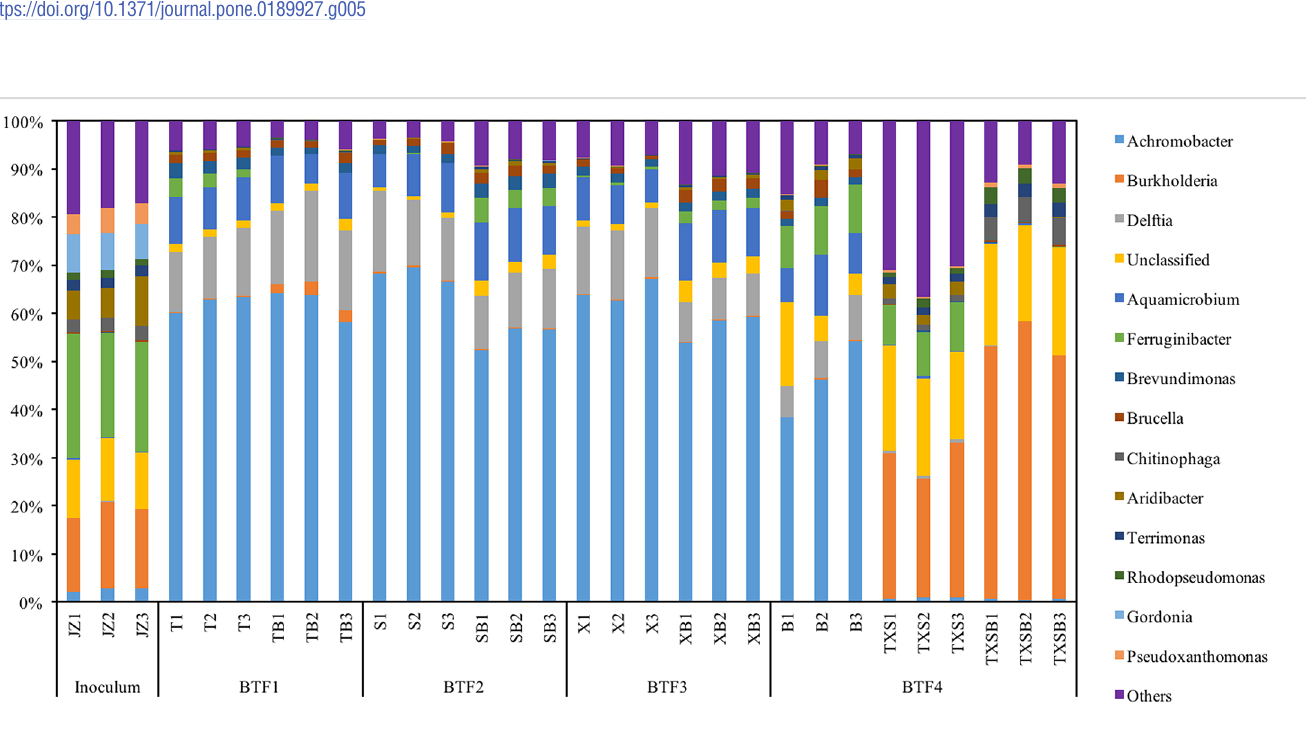
PLOS ONE | https://doi.org/10.1371/journal.pone.0189927 January 2,